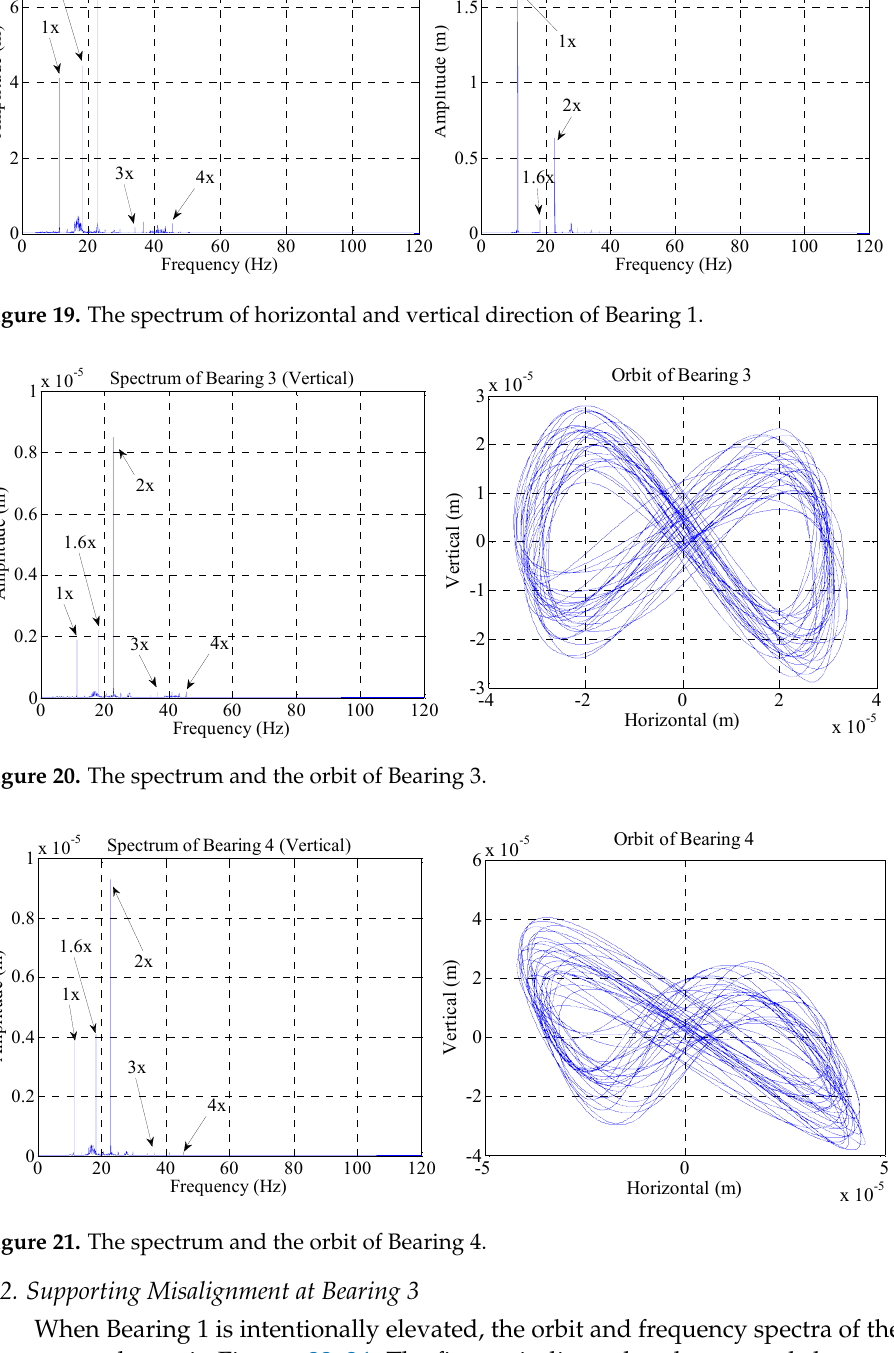
Figure 18. The vibration displacement and orbit of Bearing 1.